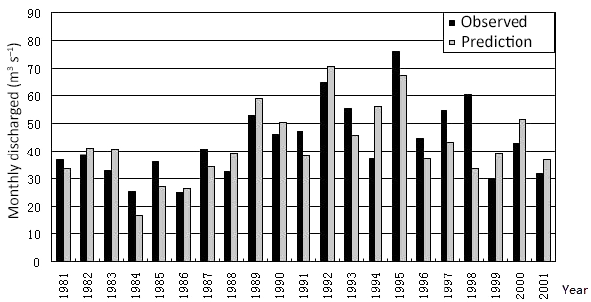
Figure 2. Predicted and observed monthly discharge in March at the Jiangqiao